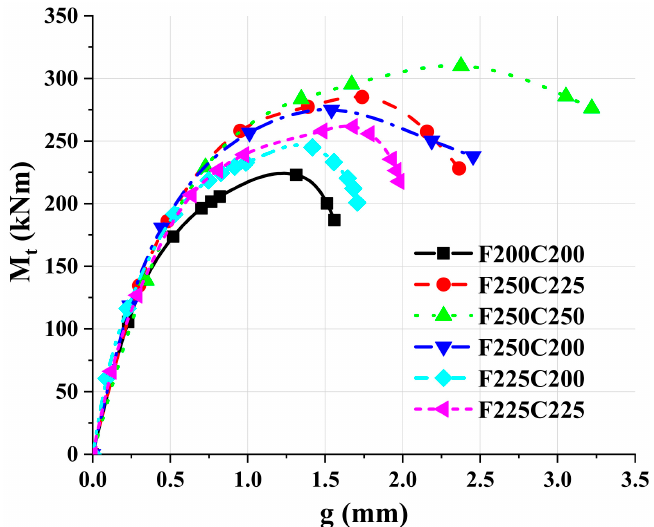
Figure 26. Moment-relative dislocation curves of connections with different beam height.